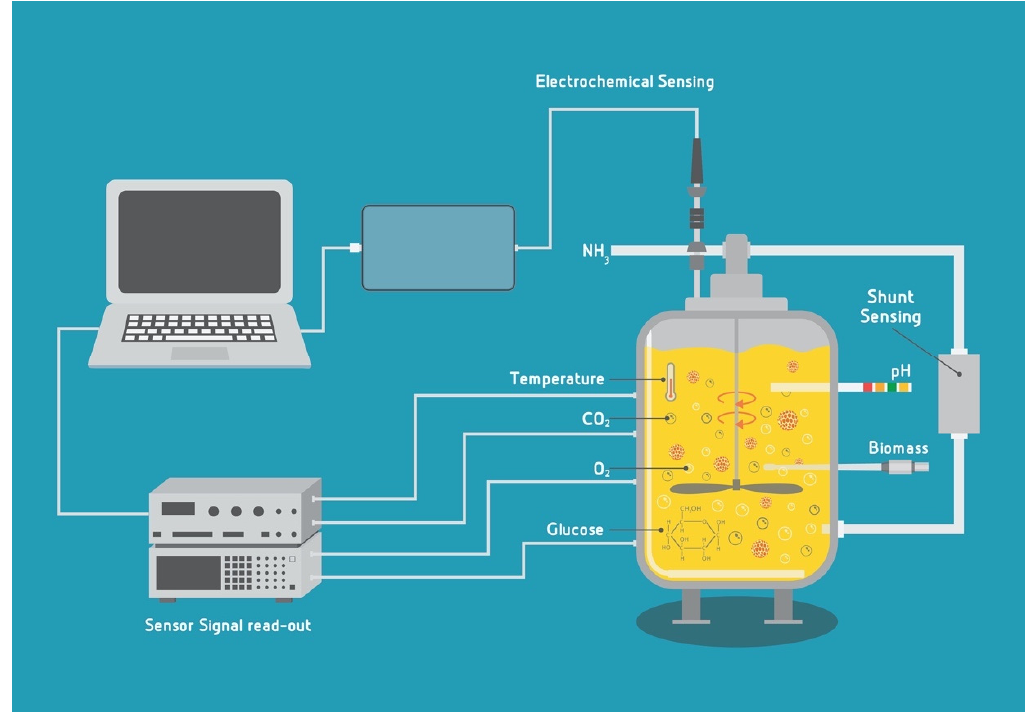
Figure 2. Main milieu parameters in meat cultivation.